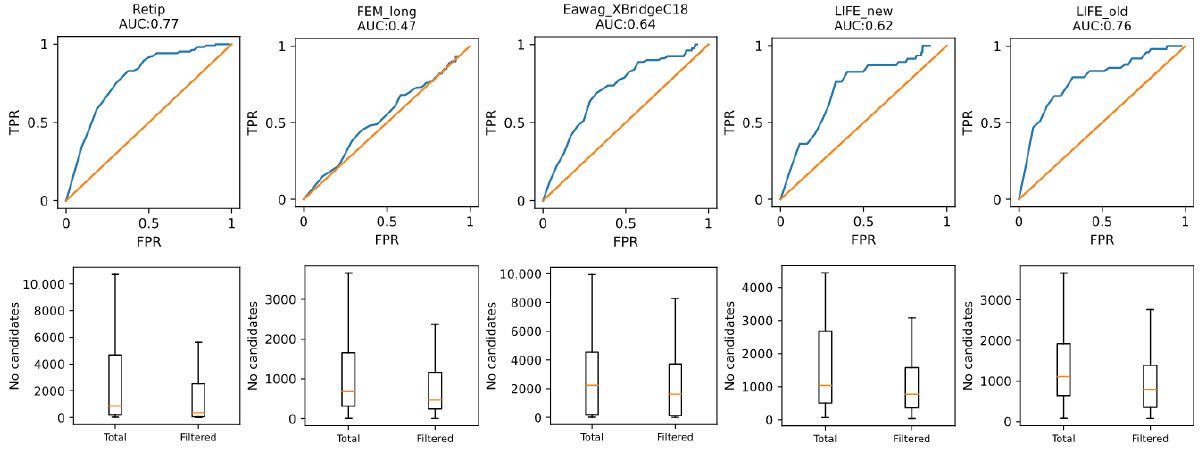
Figure 4. ROC curves and eliminated false identities.